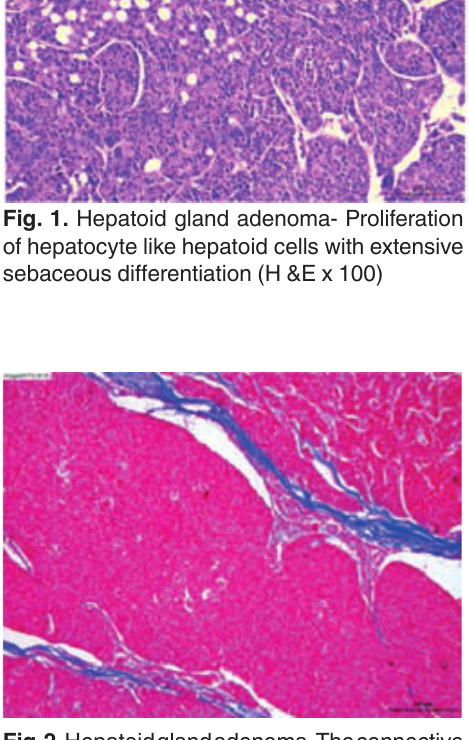
Fig. 2. Hepatoid gland adenoma- The connective tissue stroma dividing the tumour growth into lobules appeared as blue (Masson’s trichrome x 200) in Masson’s trichrome staining